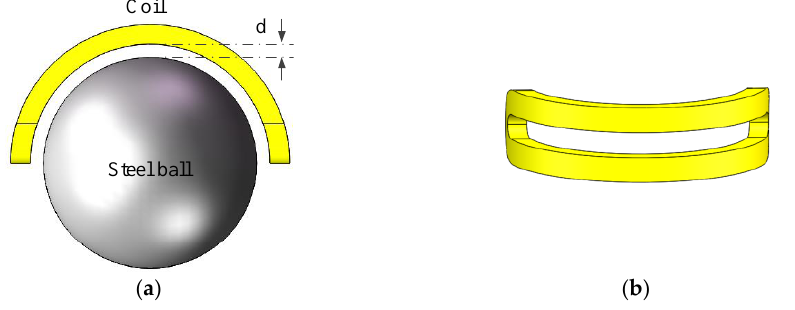
Figure 2. Model of steel ball surface detection based on SECS. ( a ) Distance between the coil and the steel ball; and ( b ) the structure of SECS coil.